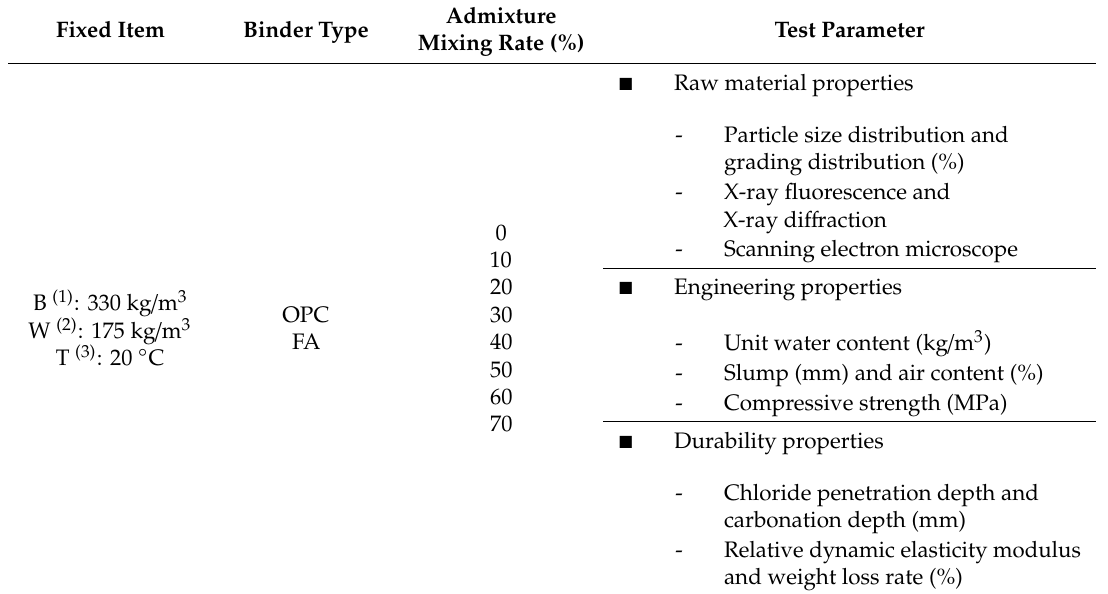
Table 3. Experimental design.